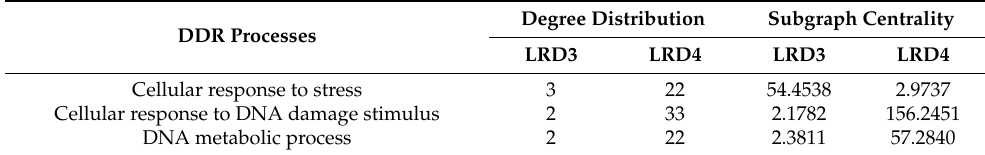
Table 4. Network measures for hub gene AT3G27060 in the subnetwork for the cellular response to stress process (row 1), cellular response to DNA damage stimulus (row 2) and DNA metabolic process (row 3) under low radiation